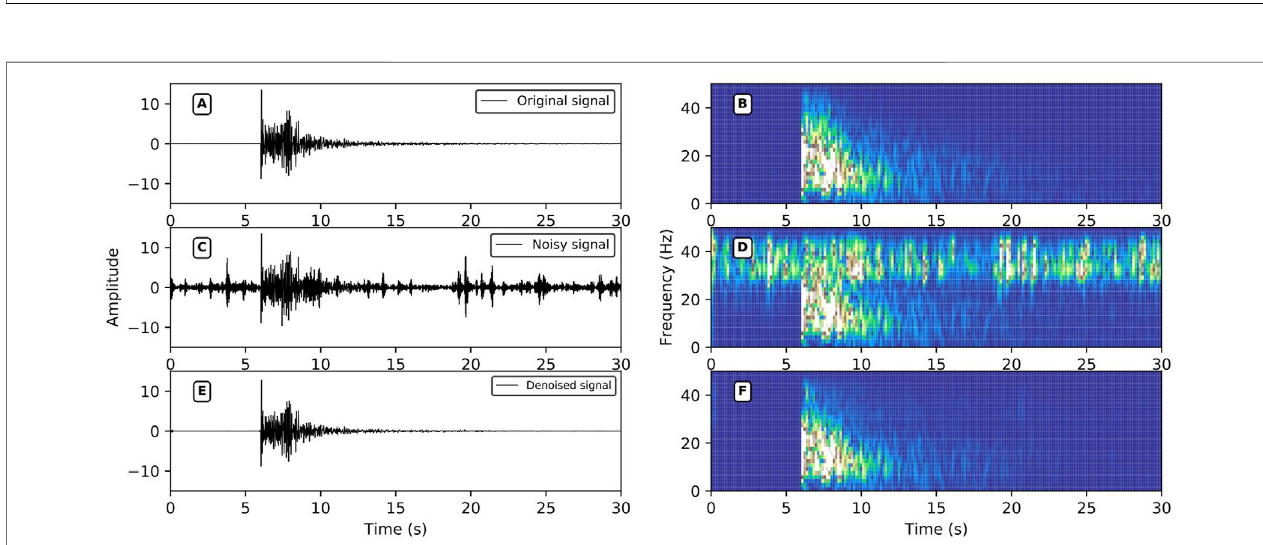
FIGURE 9 | High-frequency noise reduction performance. (A , C,E) are the original signals, the noise signal, and the signal after noise reduction in the time domain; (B,D,F) are the time-frequency domain data of (A,C,E) ; the signal SNR after adding noise (cid:1) − 0.11 dB, r (cid:1) 0.6961, SNR after noise reduction (cid:1) 15.22 dB, r (cid:1) 0.9861.